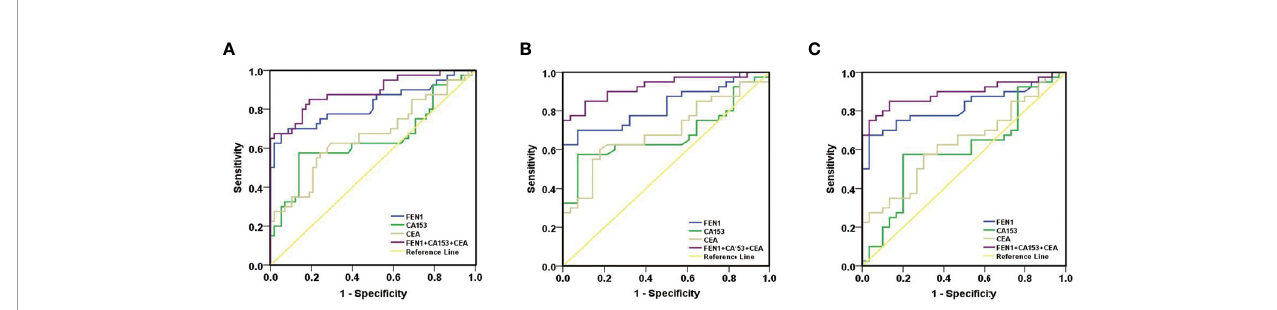
FIGURE 5 | ROC curves constructed to evaluate the diagnostic accuracy of FEN1 for early BC. (A) For distinguishing stage I + II BC patients from non-BC subjects. (B) For distinguishing stage I + II BC patients from patients with benign breast diseases. (C) For distinguishing stage I + II BC patients from healthy volunteers.